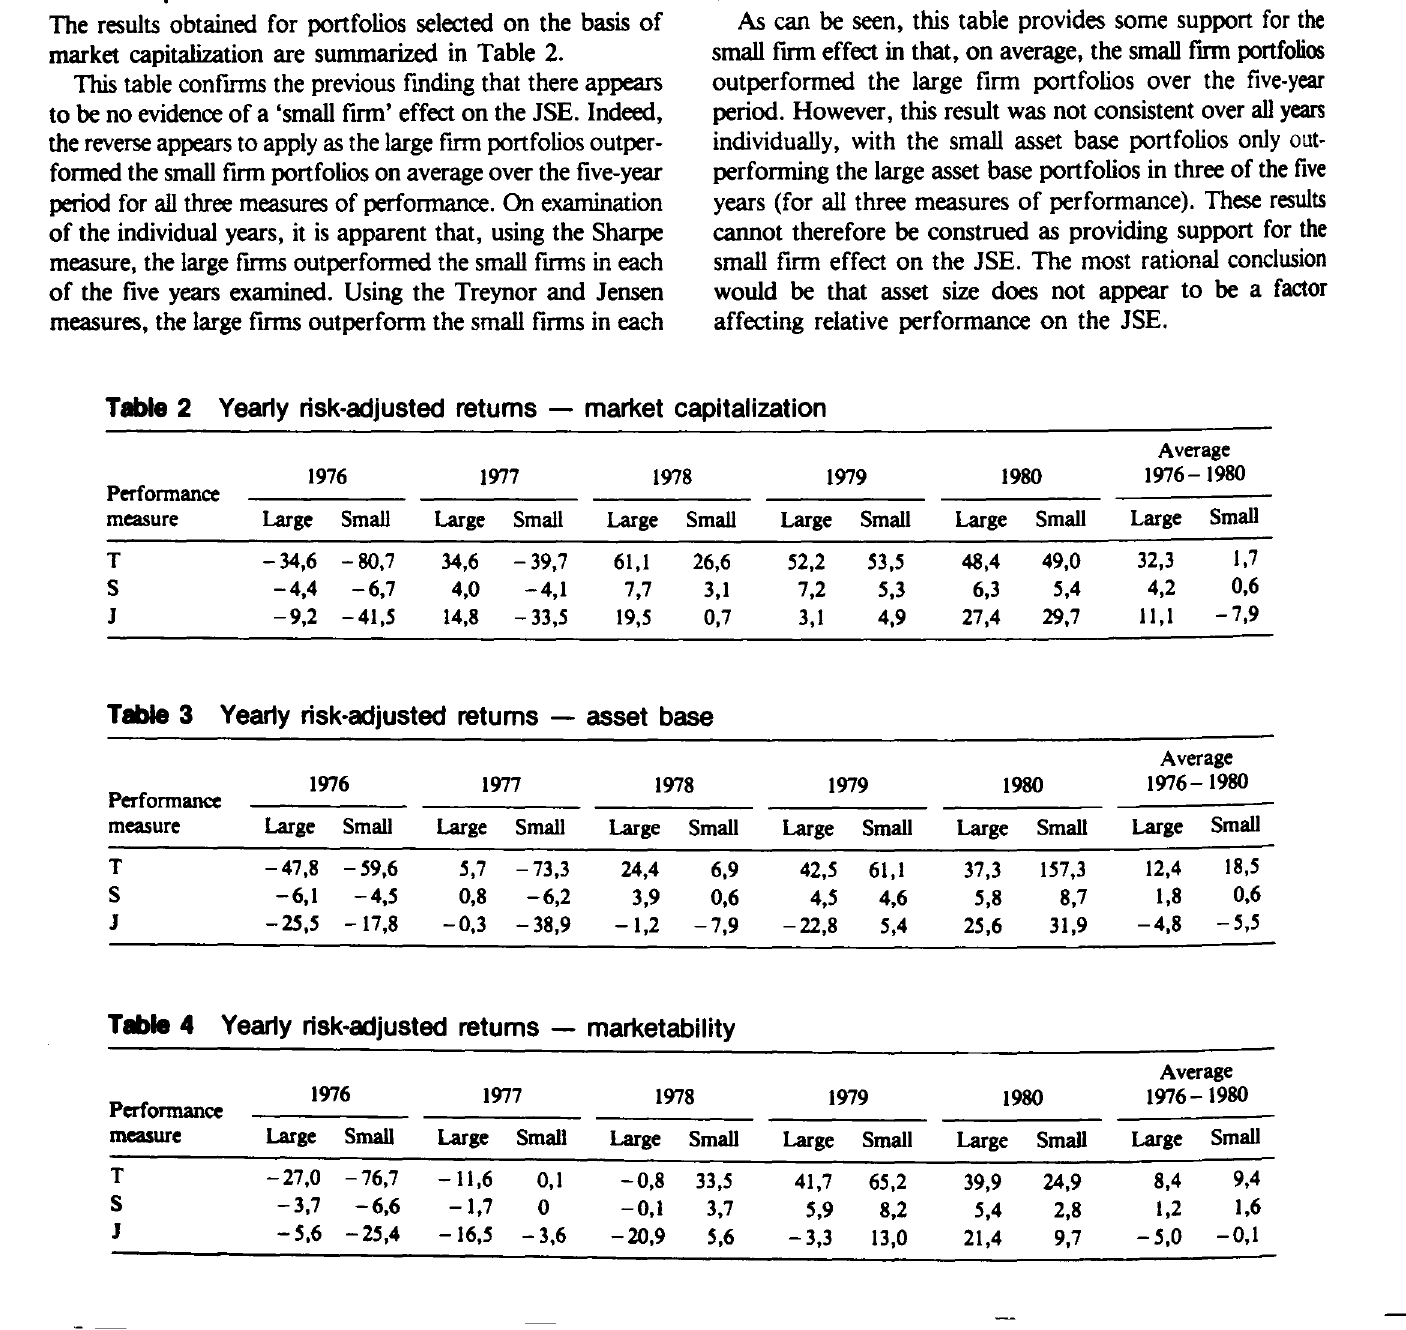
Yearly risk-adjusted returns